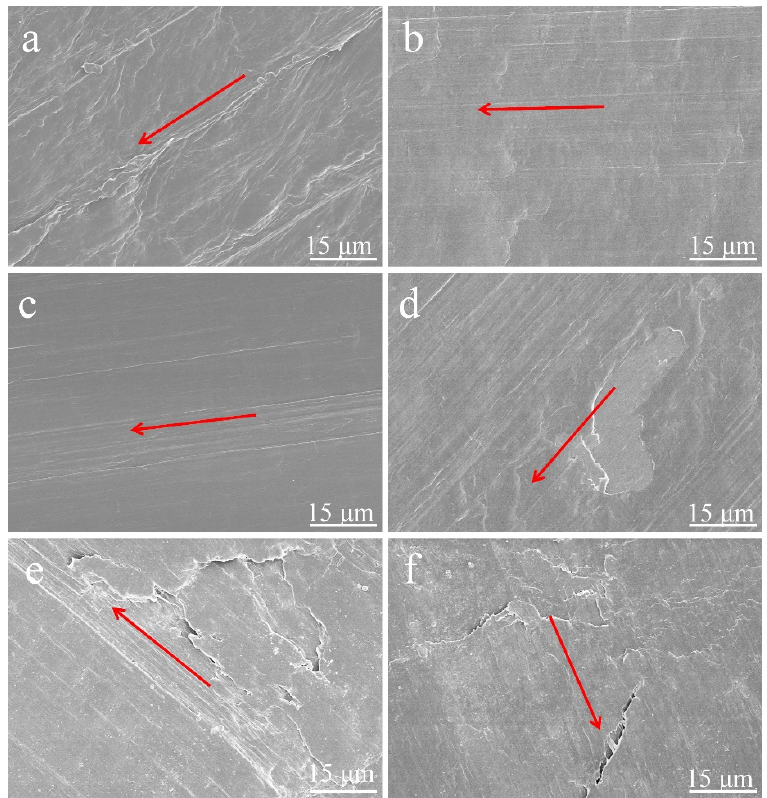
Figure 10. SEM images of worn surfaces of ( a ) pure HDPE and its composites: ( b ) 1.5ARHA/PE, ( d ) 5ARHA/PE, ( f ) 15ARHA/PE, ( c ) 1.5SiO 2 /PE, and ( e ) 1.5WRHA/PE. Arrows indicate sliding direc-